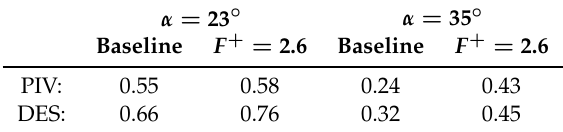
Figure 11. Mean aerodynamic coefficients of longitudinal motion for three angles of attack, comparing the baseline with actuated cases and WTT with CFD. ( a ) Lift coefficient; ( b ) drag coefficient; ( c ) pitching moment coefficient. Table 3. Relative chordwise positions x / c r of the breakdown ( α = 23 ◦ ) and stagnation location (35 ◦ ). α = 23 ◦ α = 35